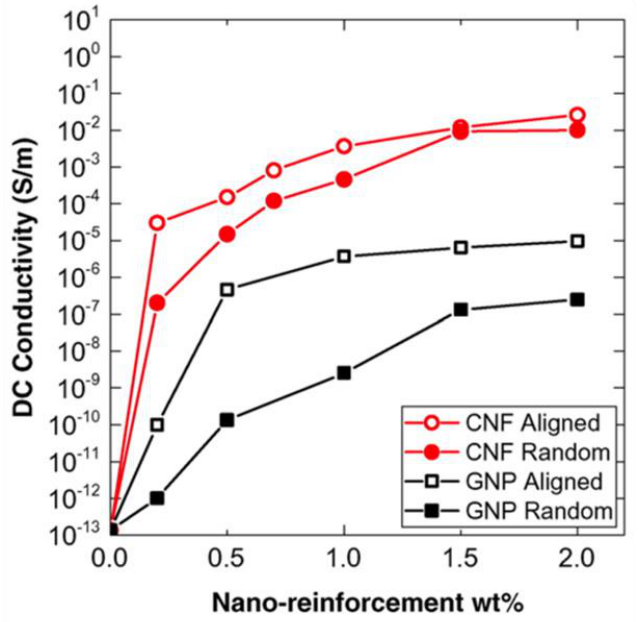
Figure 43. Effects of concentration and alignment of CNFs and GNPs on the DC electrical conductivities of epoxy-based nanocomposites. Reprinted from [114], Copyright 2016, with permission from Elsevier.